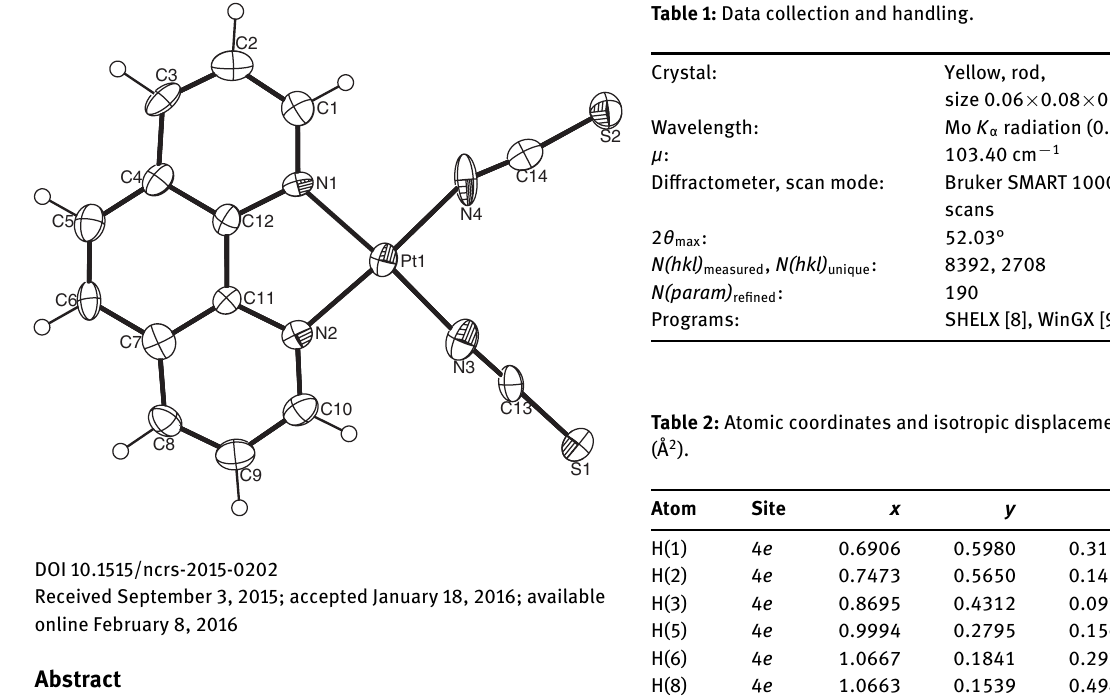
Table 1: Data collection and handling.